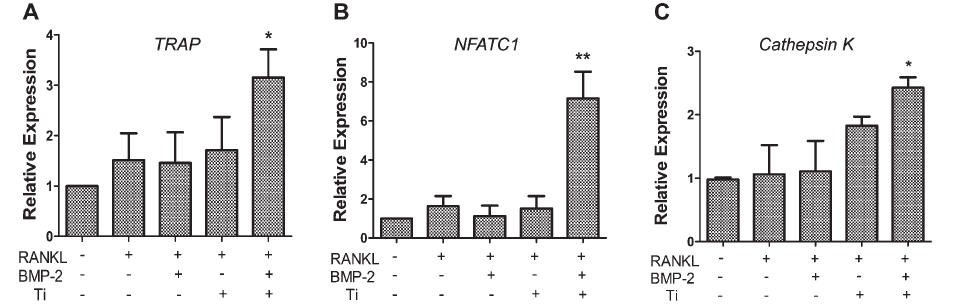
Figure 2. BMP-2 and titanium (Ti) particles synergistically activated osteoclast formation. Gene relative expression was determined by real-time PCR; RAW 264.7 cells were cultured with suboptimal (30 ng/mL) RANKL, BMP-2 (50 ng/mL) or Ti particles (150 m g/mL) as indicated for 5 days. A , TRAP gene expression. B , NFATc1 gene expression. C , Cathepsin K gene expression. Data are reported as means±SD. *P , 0.01; **P , 0.0001 (one-way ANOVA).